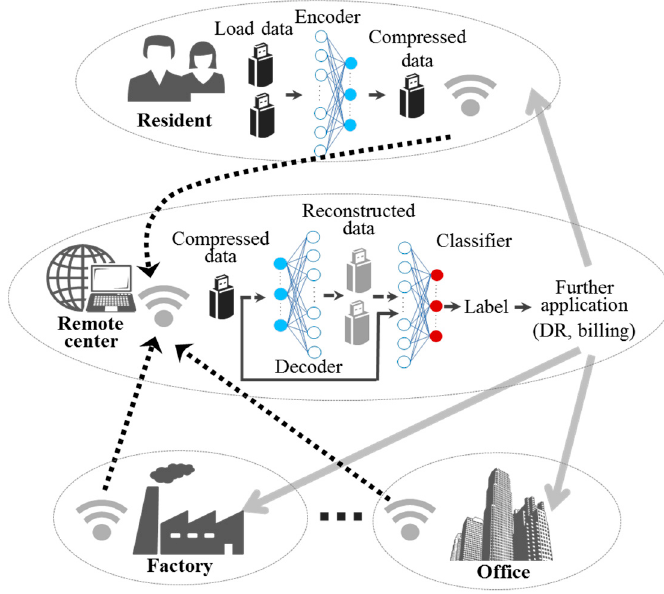
Figure 1. Framework of the proposed Artificial Neural Network (ANN)-based model.